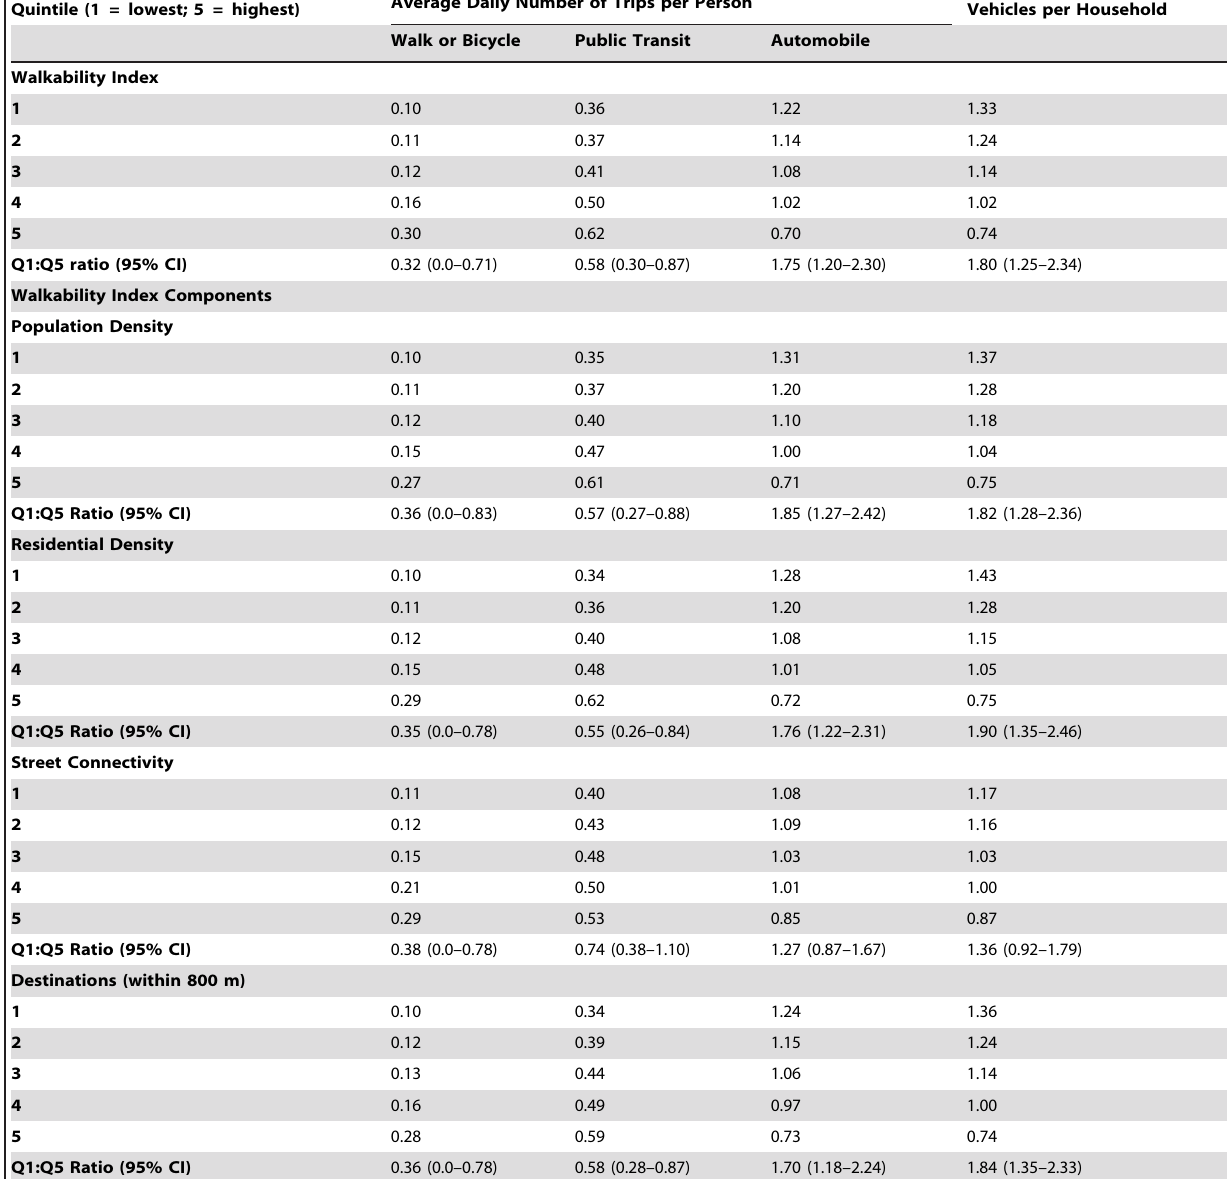
Quintile (1 = lowest; 5 = highest) Average Daily Number of Trips per Person Vehicles per